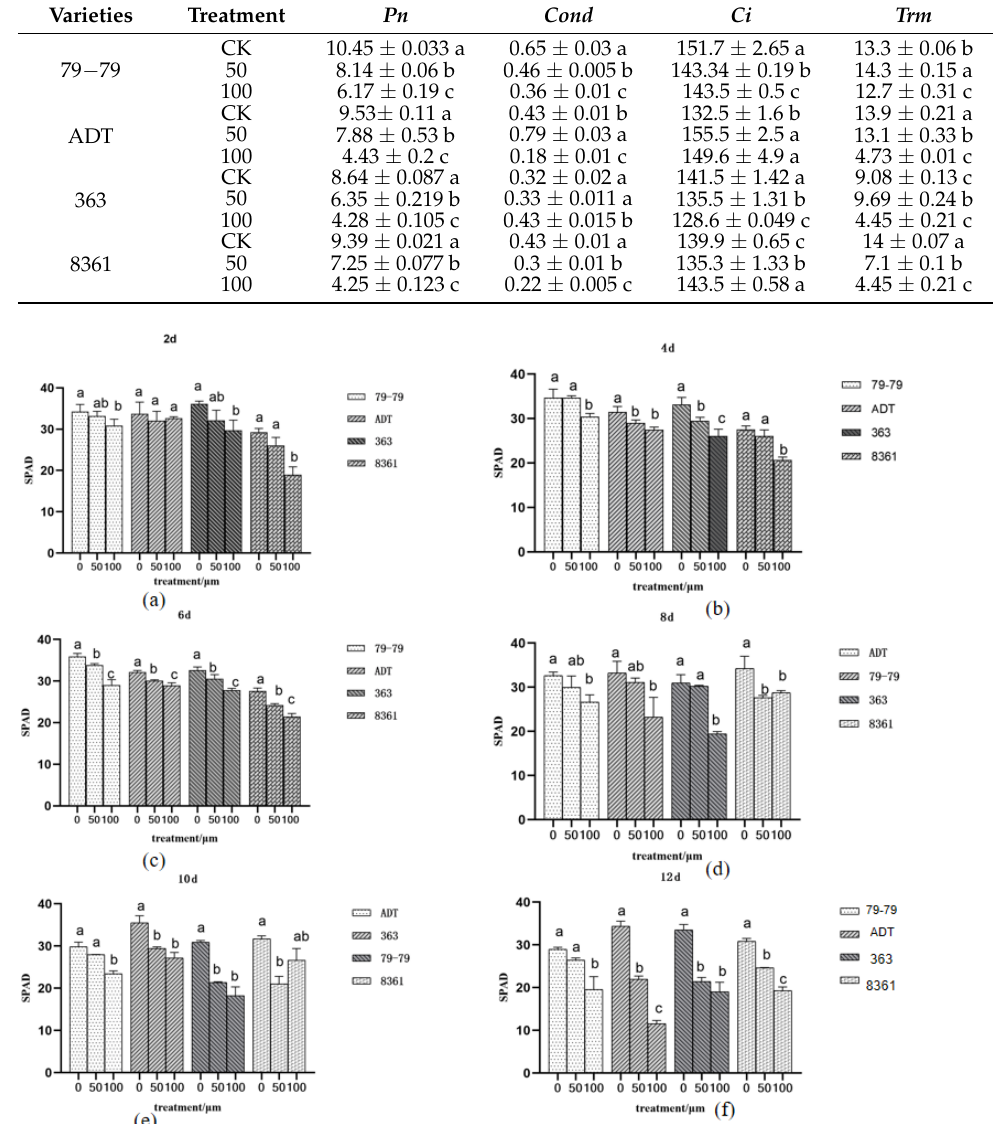
Table 2. Net CO 2 assimilation rate ( Pn ), stomatal conductance ( Cond ), transpiration rate ( Trm ), and intercellular CO 2 concentration ( Ci ) of sunflower root under different concentrations of cadmium. Different letters indicate significant differences between treatments ( p < 0.05, Duncan’s test).